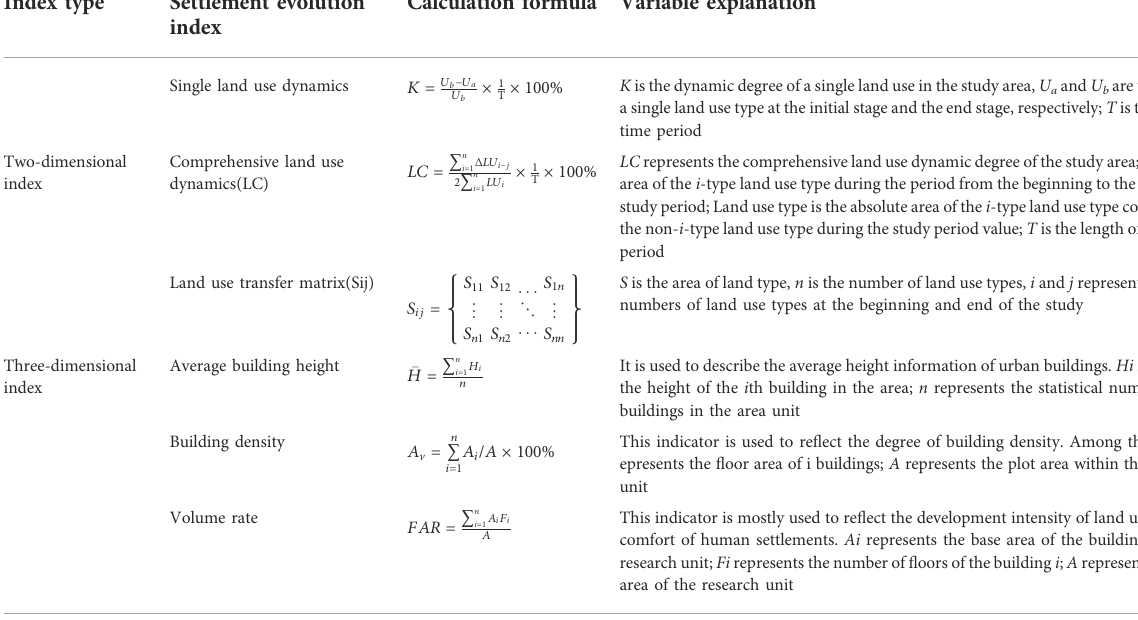
TABLE 2 Research method and